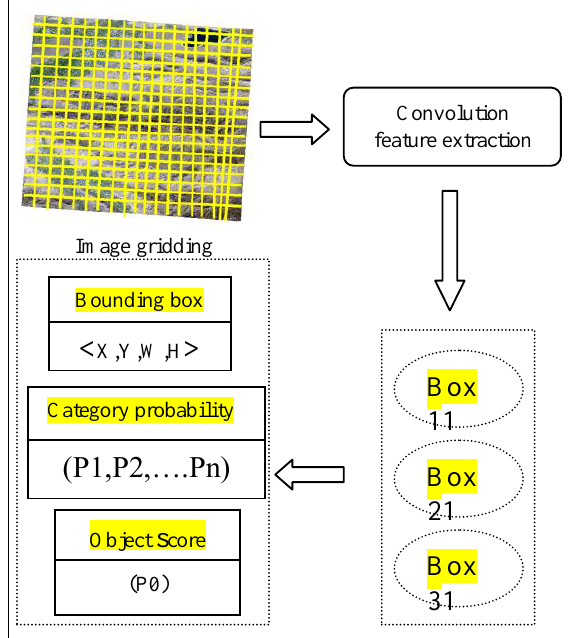
Figure 3. YOLOv3 mode l training process